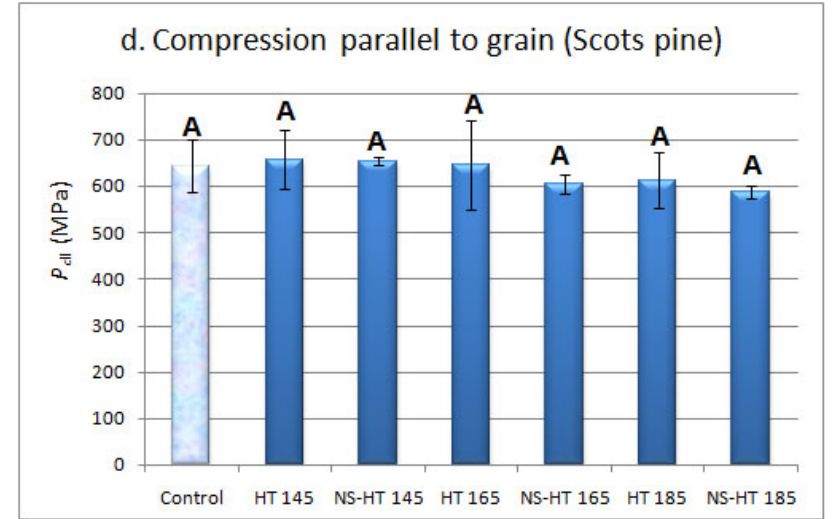
Figure 5. Mechanical properties, including modulus of rupture ( a ), modulus of elasticity ( b ), impact bending ( c ), and compression strength parallel to grain ( d ) in pine specimens heat-treated at 145, 165, and 185 ◦ C and impregnated with silver nanosuspension (HT = heat-treated at a determined temperature; NS = nano-silver impregnated. MOR = modulus of rupture; MOE = modulus of elasticity. Letters on each column represent statistical groupings of mean values based on Duncan’s Multiple Range test at 95% level of confidence. Error bars represent standard deviation).